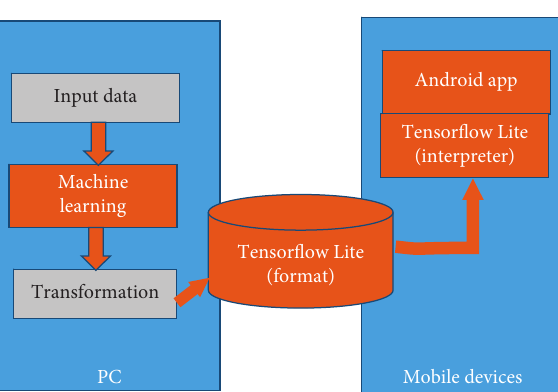
Figure 1: The proposed system works on workstations and mobile devices.